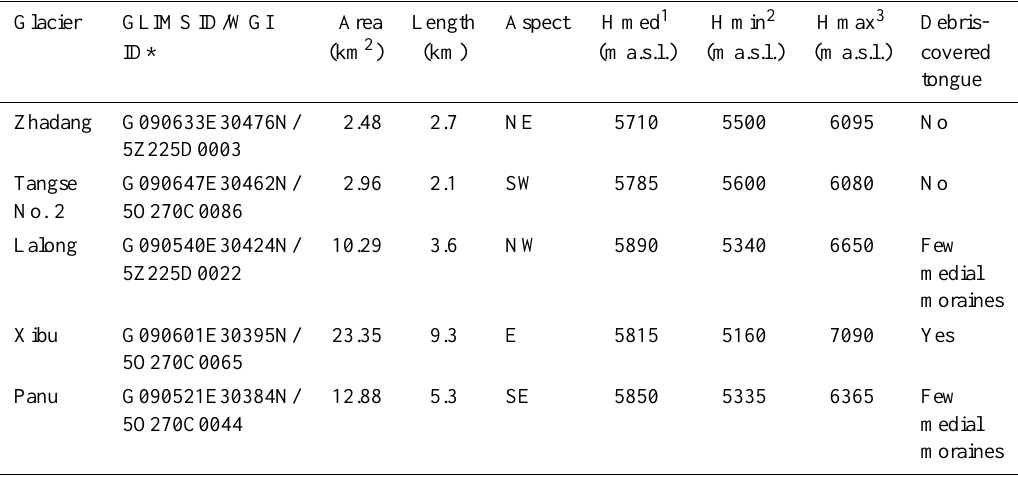
Table 3. Characteristics of the glaciers investigated in detail based on the 2001 extents. Glacier GLIMS ID/WGI Area Length Aspect Hmed 1 Hmin 2 Hmax 3 Debris- ID* (km 2 ) (km) (ma.s.l.) (ma.s.l.) (ma.s.l.) covered